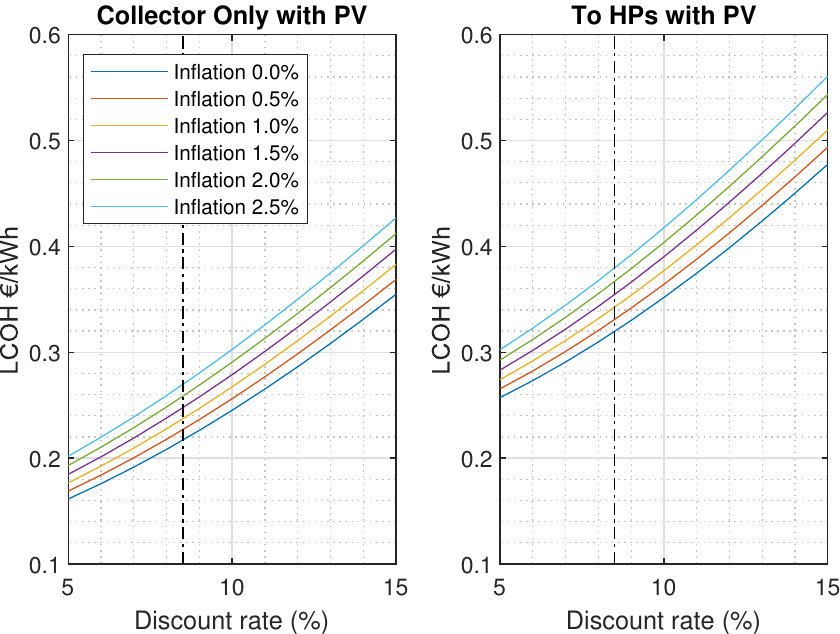
Figure 17. Effect of the discount rate on the final LCOH of the hybrid collector only with PV ( left ) and of the integrated hybrid collector feeding first the heat-pump and chillers ( right ). The vertical dotted line corresponds to